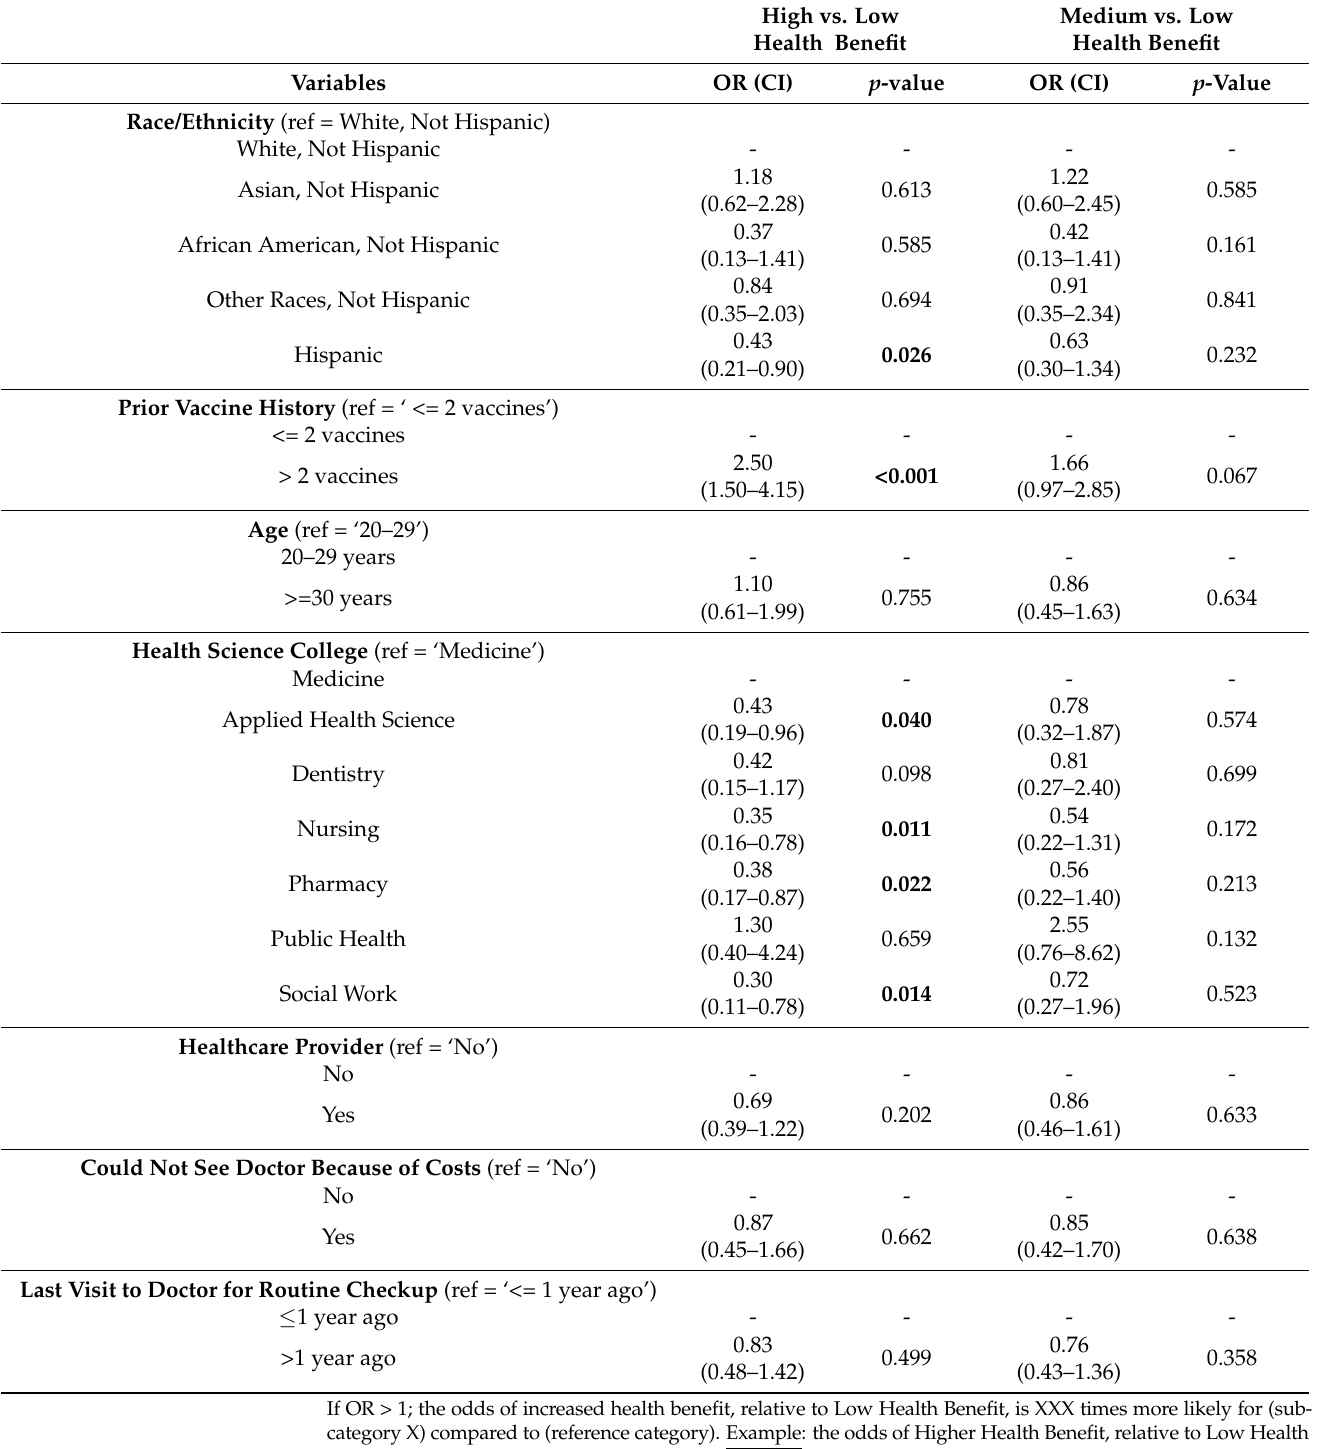
Table 5. Multinomial logistic regression on health benefit scoring